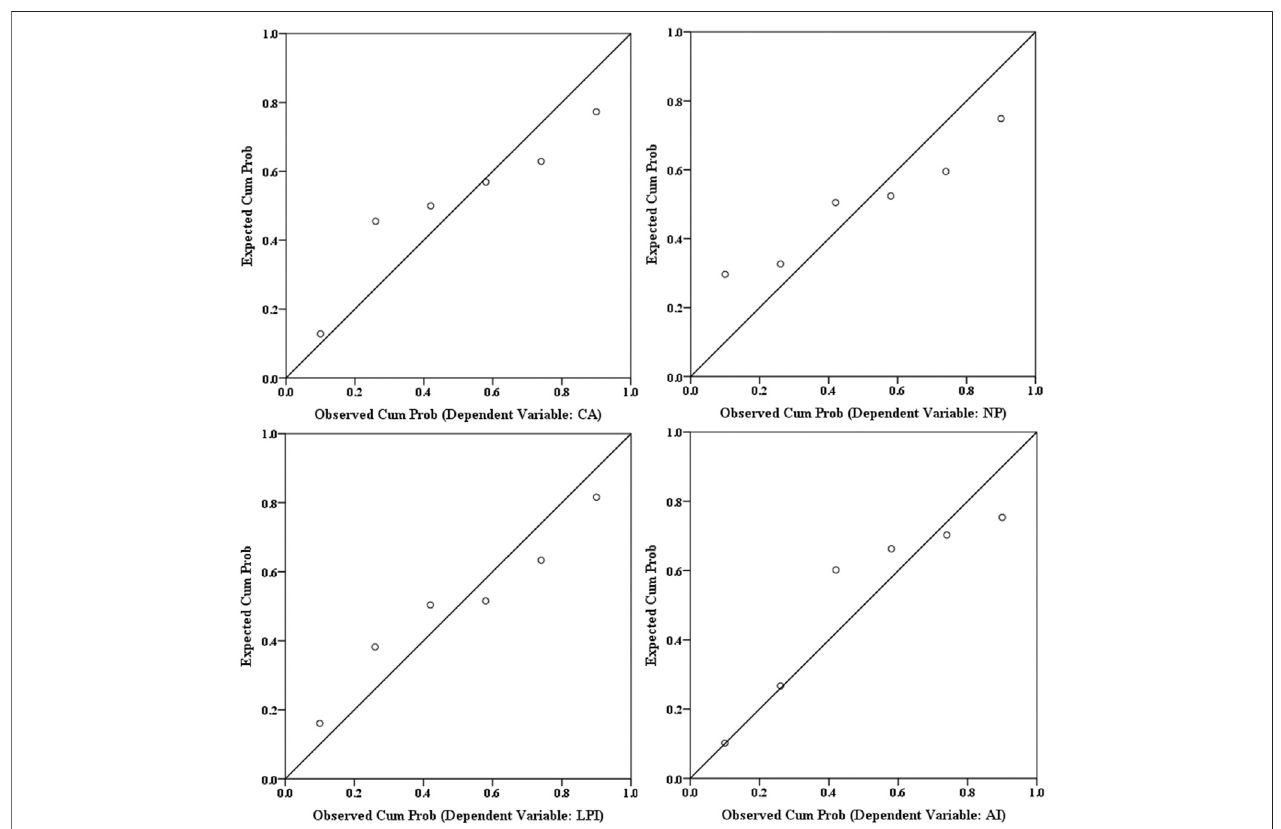
FIGURE 6 | The normal probability plots of regression standardized residuals of optimal GLMs.